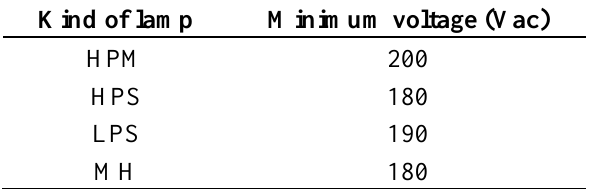
Table 12. Minimum voltage regarding the kind of lamp according to GE